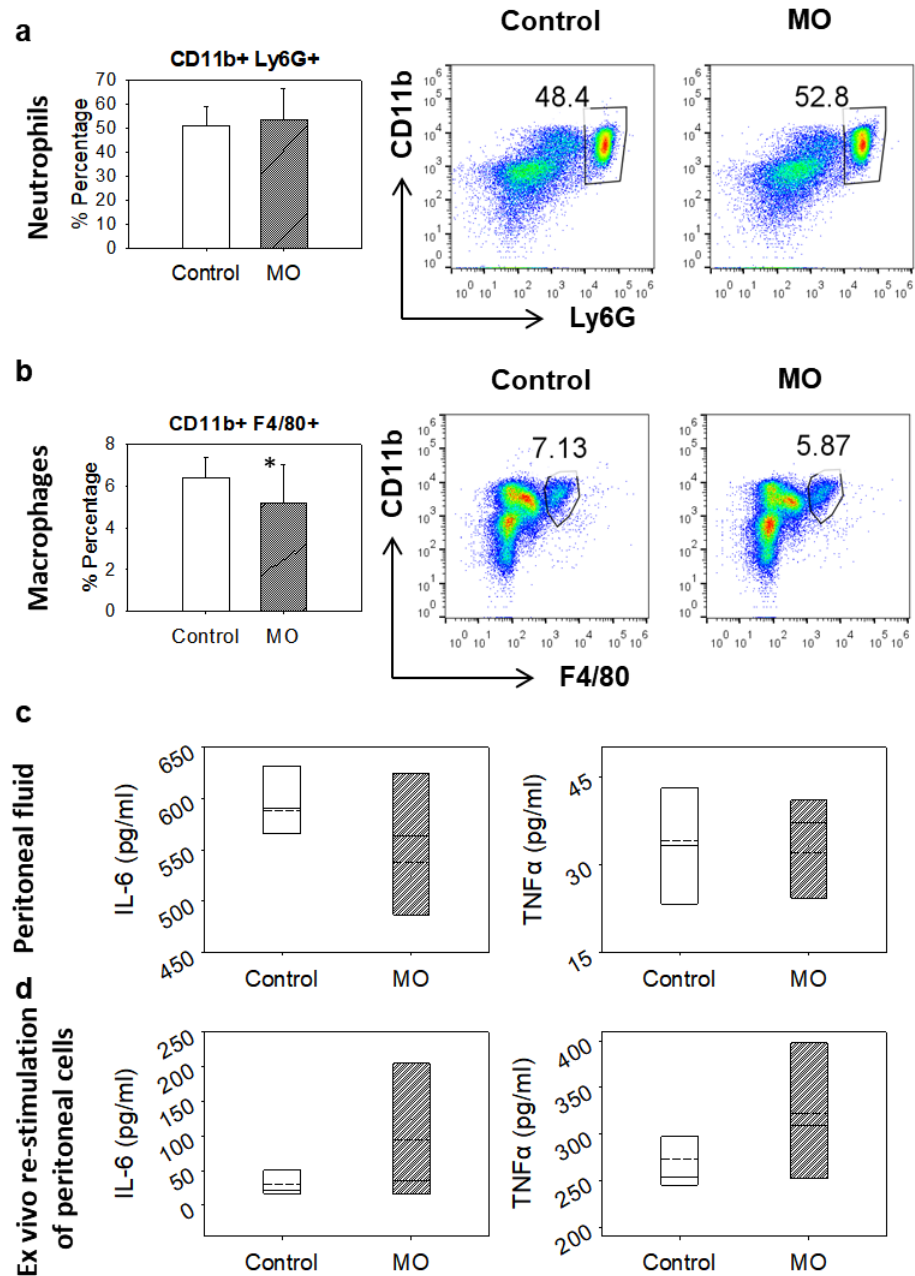
Figure 1. Effect of orally administered MO in the zymosan-induced peritonitis BALB/c mouse model. ( a ) Neutrophil and ( b ) macrophage recruitment in the peritoneal cavity 6 h after zymosan challenge, analysed by flow cytometry. Treated mice ( n = 7) received 0.58 g/kg body weight of MO orally in a 10% v/v mixture with corn oil for three days prior to zymosan administration. Control animals received an equal volume of plain corn oil. Bars in ( a , b ) represent the percentage of CD11b+ Ly6G+ (neutrophils) or CD11b+ F4/80+ (macrophages) cells, respectively. ( c ) Peritoneal IL-6 and TNF- α levels 6 h after zymosan challenge, determined by ELISA. ( d ) IL-6 and TNF- α levels analysed by ELISA, in the supernatants of cells migrated to peritoneum, collected from either control or MO-treated animals and rechallenged with zymosan ex vivo for 24 h. Box plots of the cytokine levels in ( c , d ) represent the first to the third quartiles; solid lines indicate median and dashed lines indicate mean values. Data are representative of at least three independent experiments. Asterisk indicates statistically significant difference compared to control (Student’s t -test, p ≤ 0.05 ).